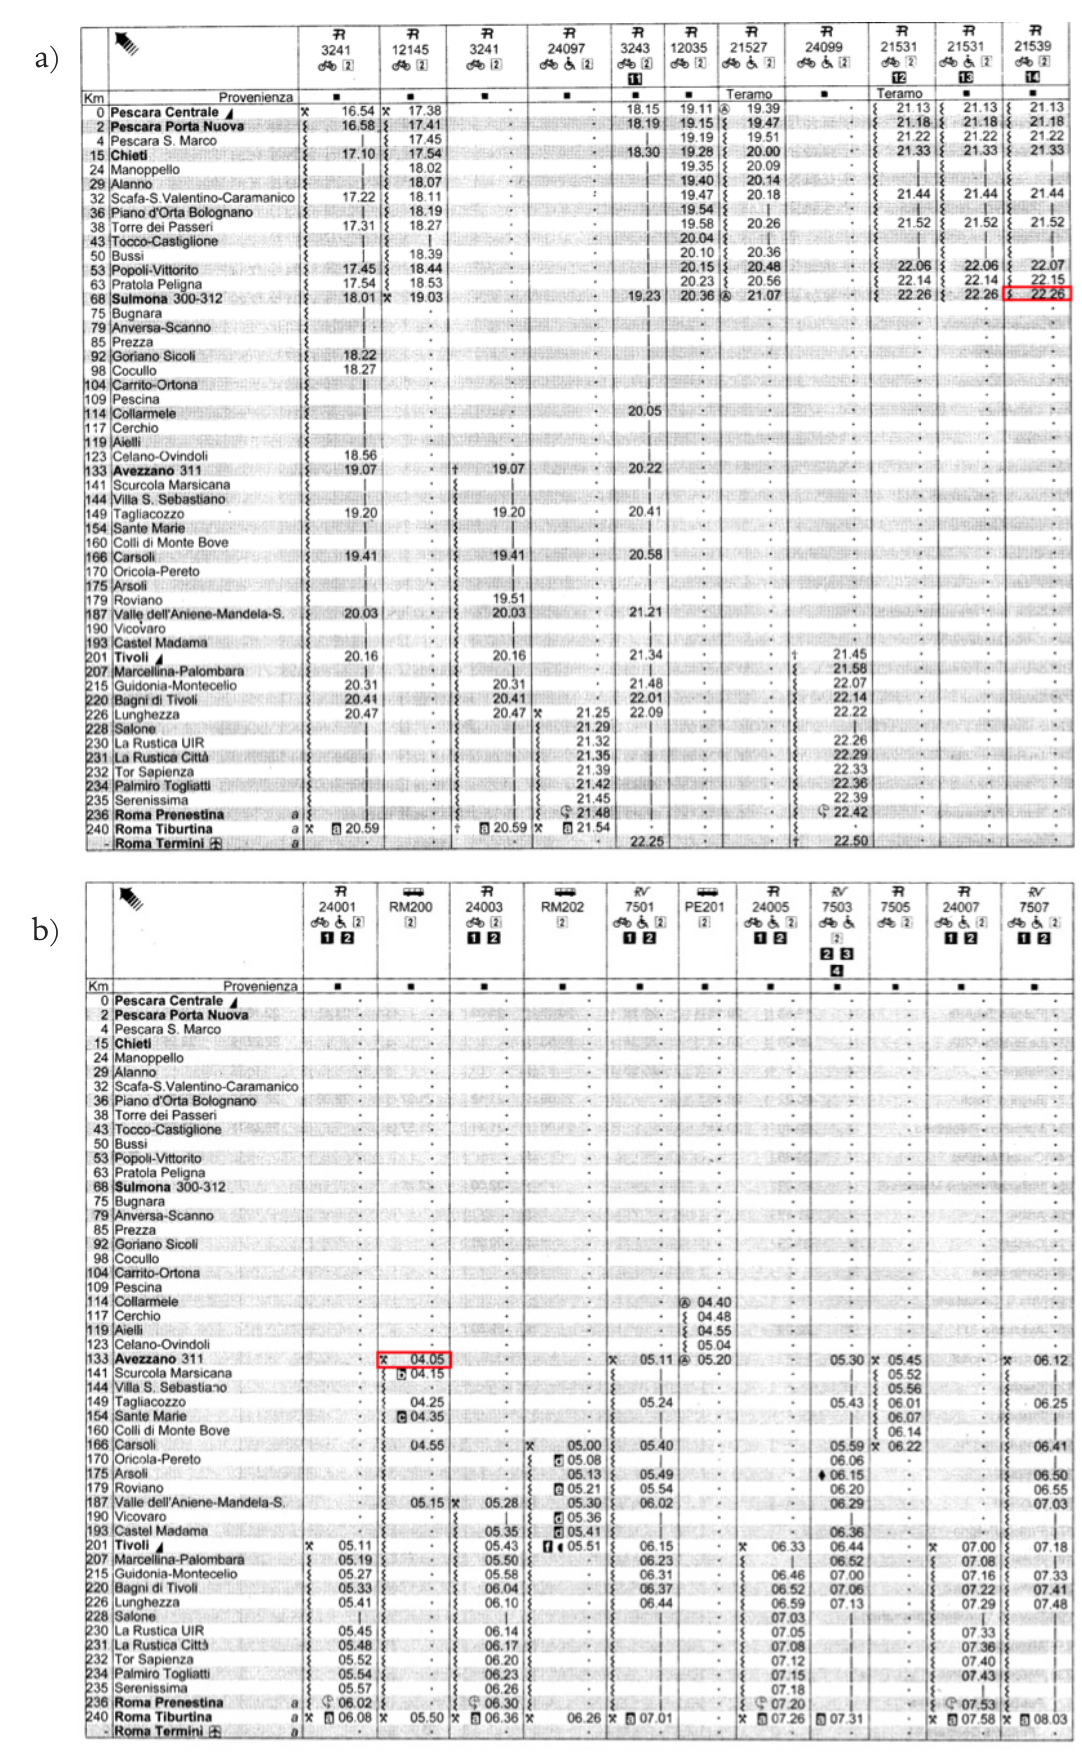
Table 1. Timetable of railway stations: in red, the last arrival in the evening (a) and the first leaving in the morning (b) within nearest track to L’Aquila